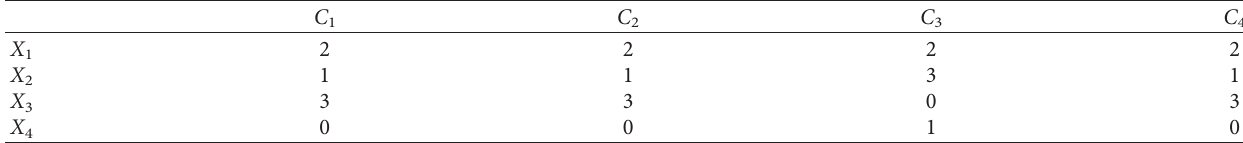
Table 10: Values of negative flow Φ − .